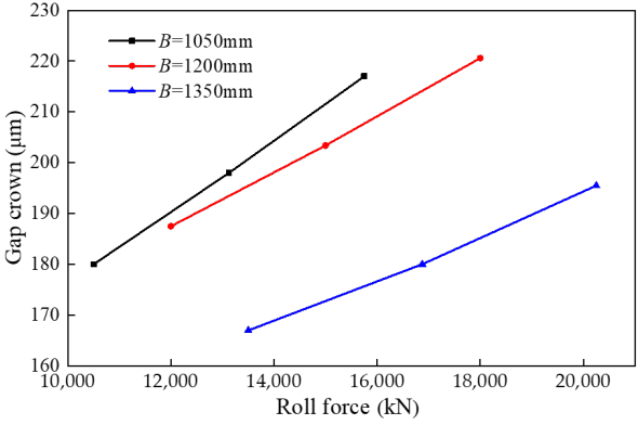
Figure 10. The influence of the rolling force on the gap crown. Table 10. Transverse stiffness with different strip widths.